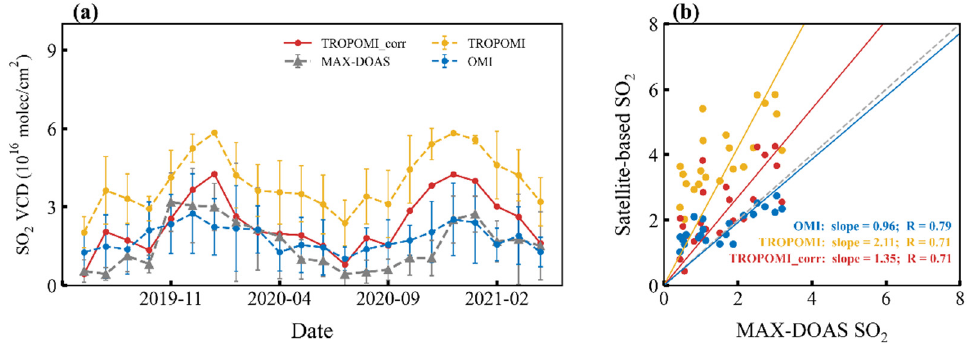
Figure 7. ( a ) Same as Figure 3a, but for SO 2 . ( b ) Same as Figure 3b, but for SO 2